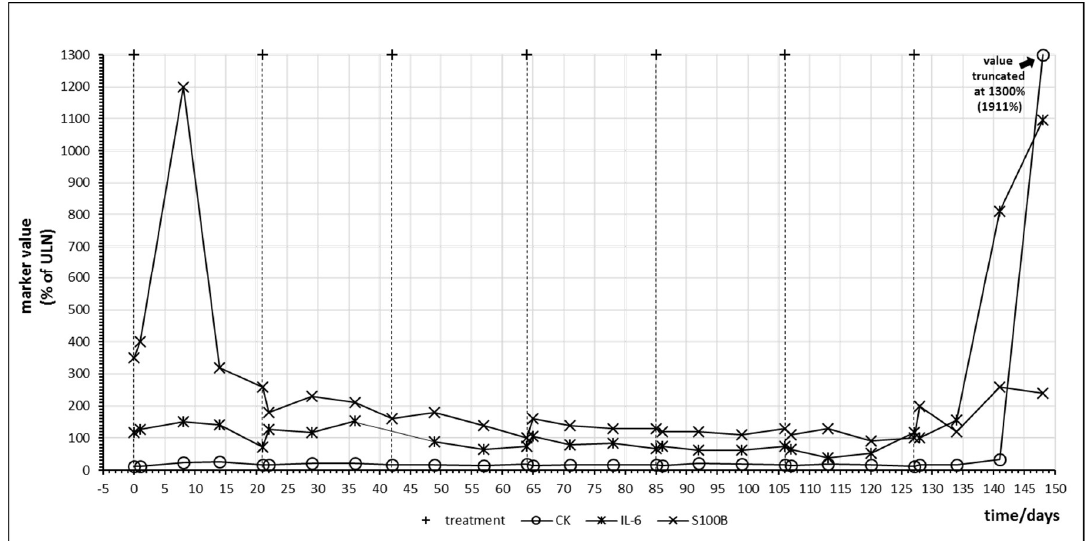
Figure 4. Time course of immune, tumor and cell damage (creatine kinase (CK)) markers during checkpoint inhibitor treatment starting at day 0. Patient no. 5, 7 cycles of pembrolizumab.